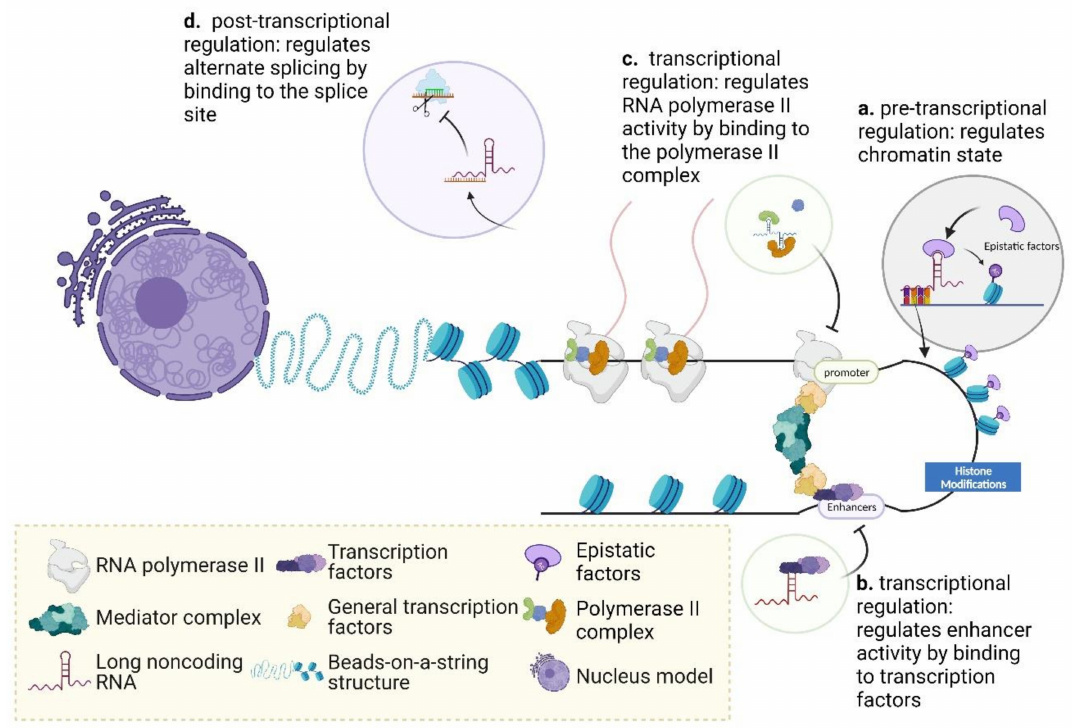
Figure 3. The regulatory mechanisms of Long Noncoding RNAs. During transcription, RNA poll II binds to the core promoter via transcription